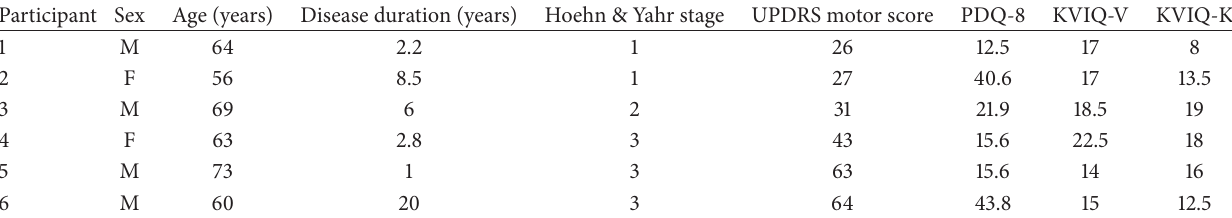
Table 1: Participant demographics and background